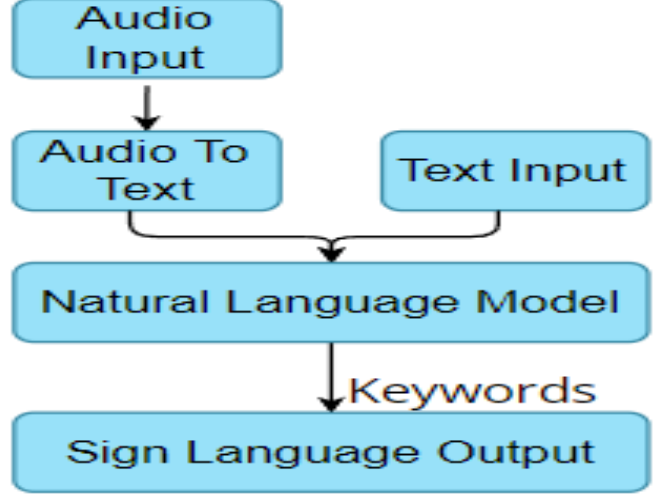
Figure 4. System